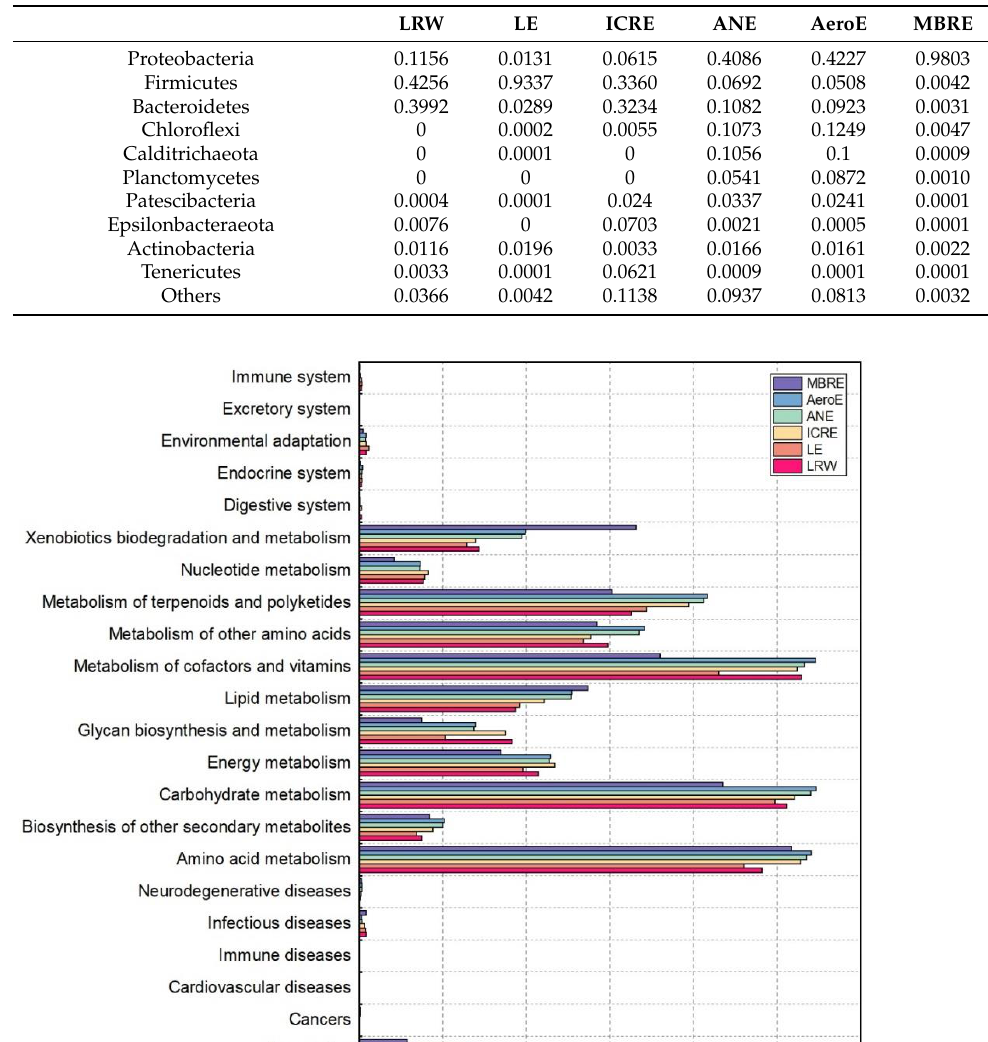
Table 3. Bacterial taxonomic identification and relative abundances at the phylum level in each leachate sample at different water outlets.